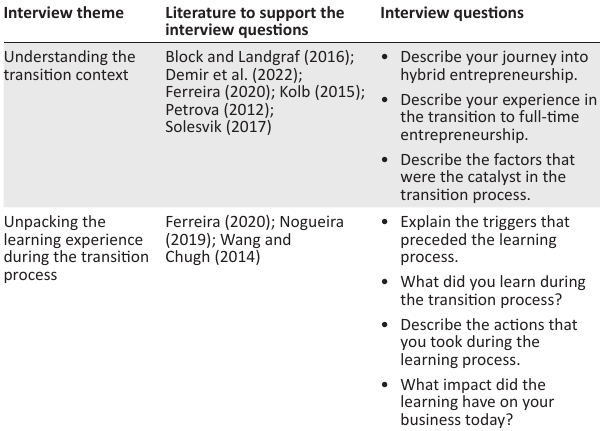
TABLE 2: Interview